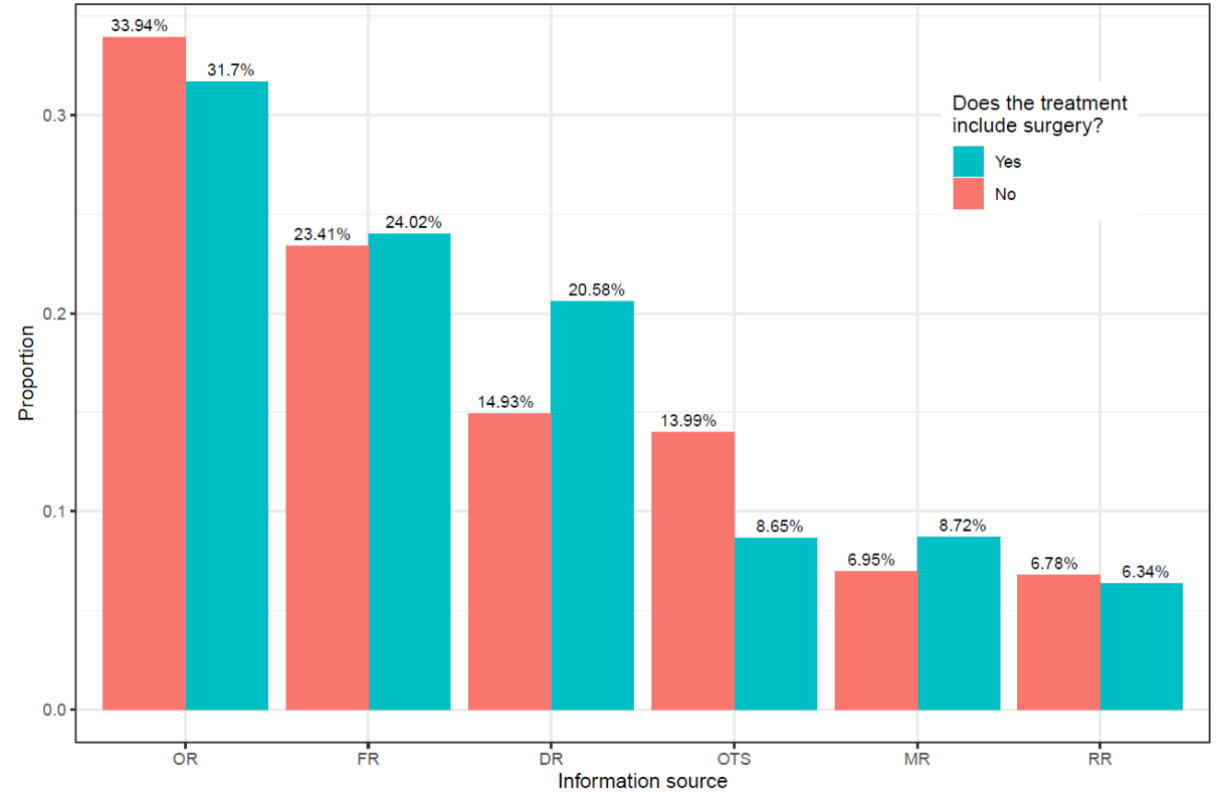
Figure 4. The influence of treatment on reasons for choosing doctors. DR: doctor recommendations; FR: family and friend recommendations; MR: multiple reasons; OR: online reviews; OTS: others; RR: random